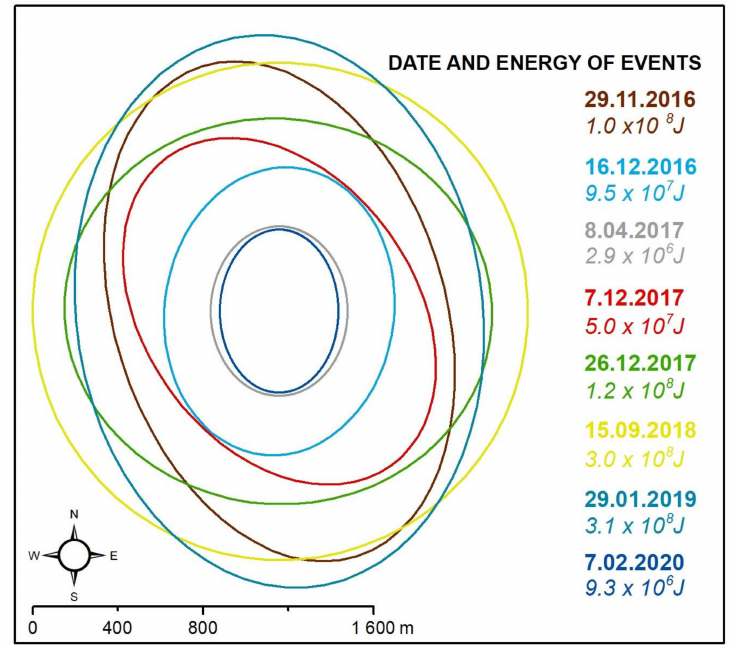
Figure 6. Superimposed spatial extents of the analyzed eight deformation